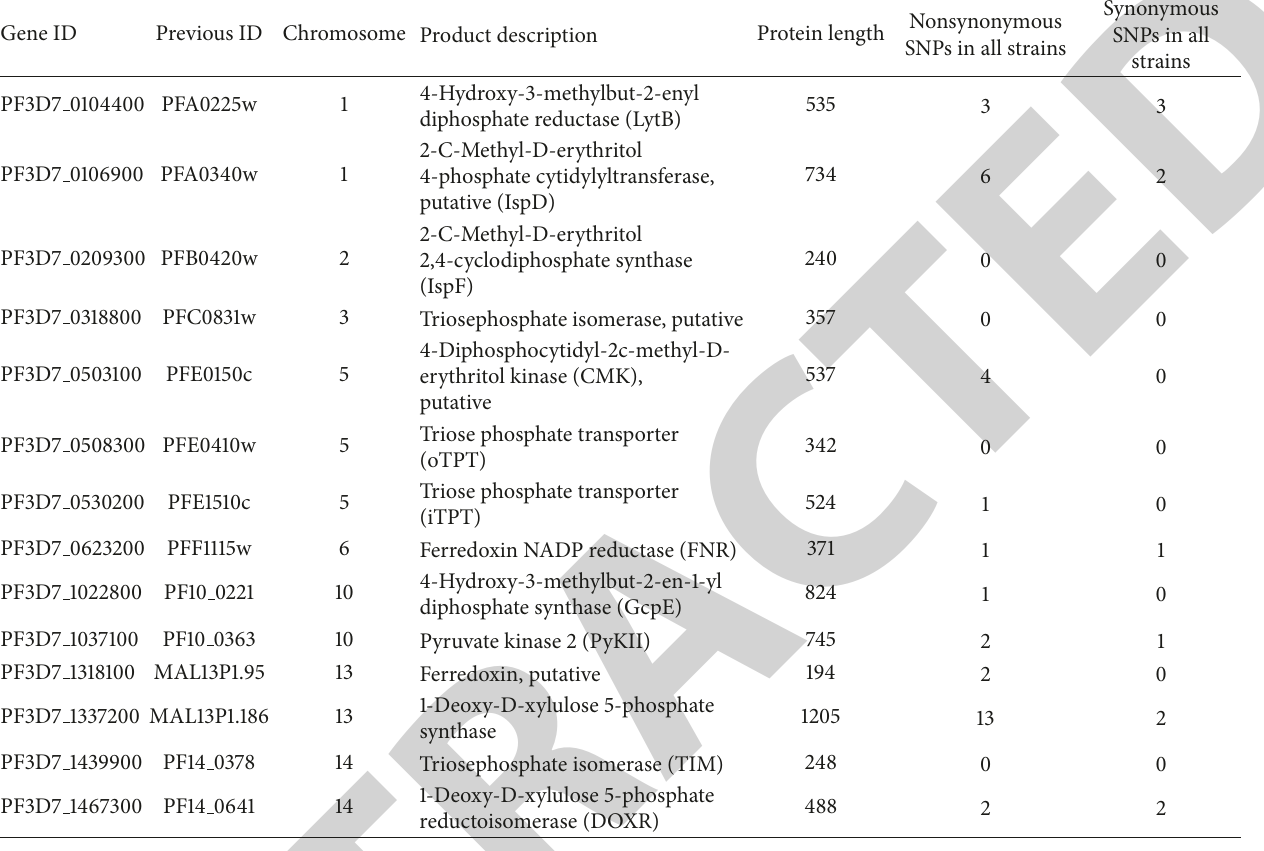
Table 1: Details of genes involved in isoprenoid metabolism and their polymorphisms in P. falciparum 3D7. Gene